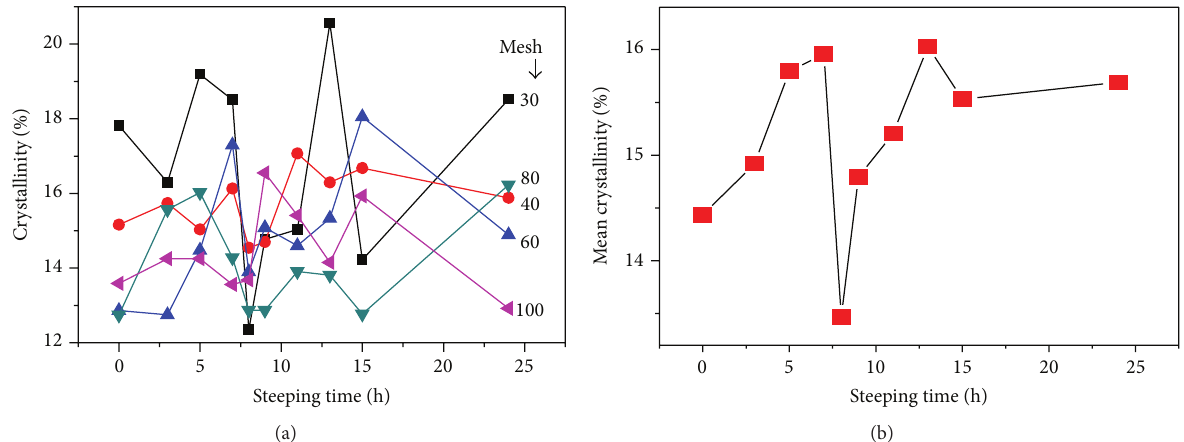
Figure 5: (a) Crystallinity of the PSD samples as a function ST for all the mesh numbers. (b) The mean value of crystallinity, averaged on the five mesh number values, against ST.